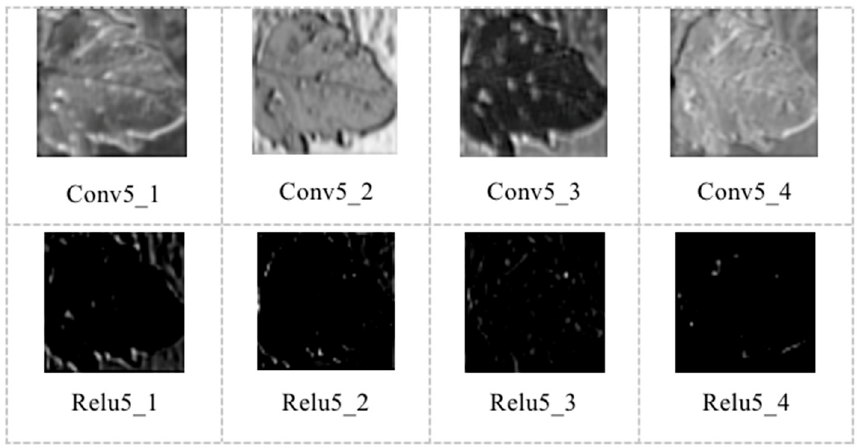
Figure 11. Output features of Conv5 and Relu5 layers.